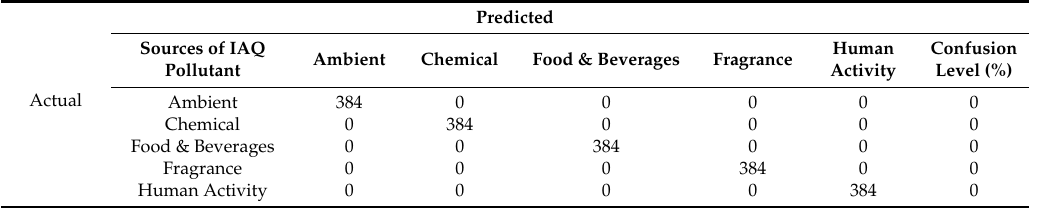
Table 11. Confusion matrix of multilayer perceptron (MLP) for vector array normalization (VAN) before principal component analysis